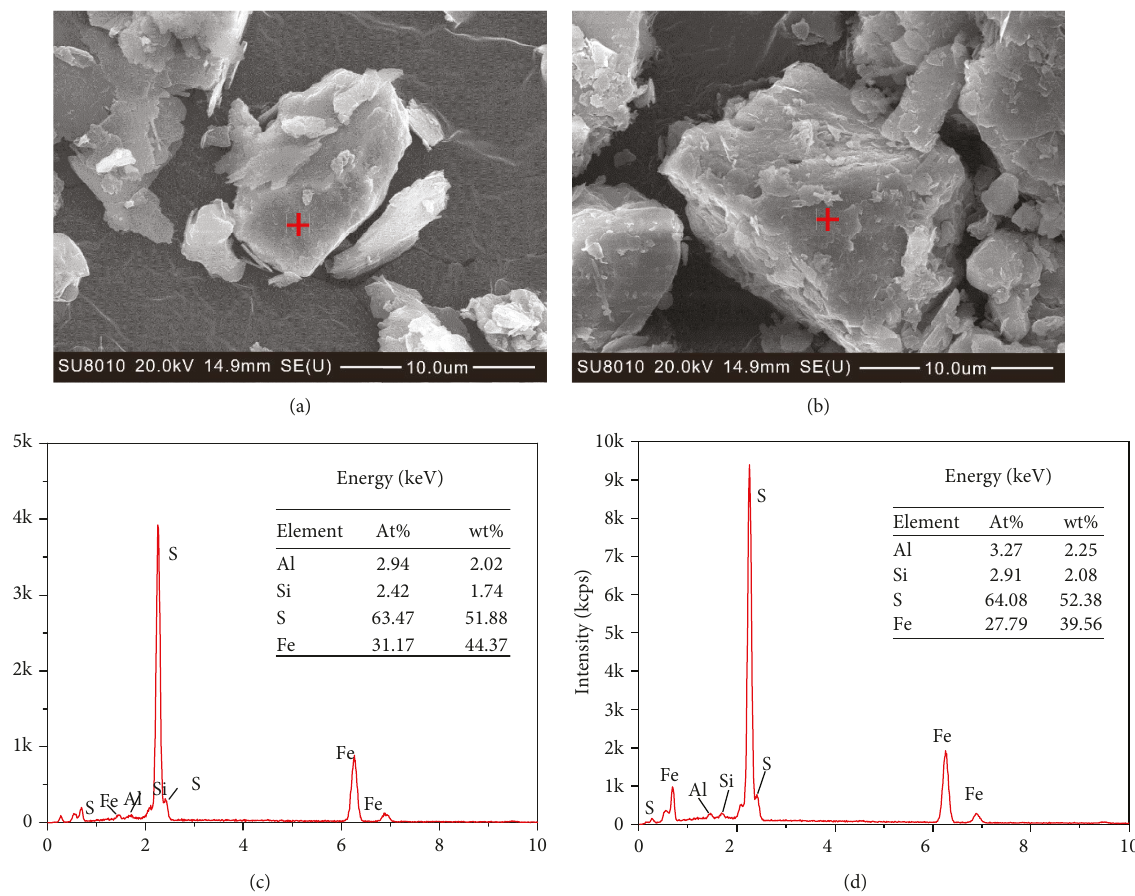
Figure 5: SEM (Scanning Electron Microscopy) and EDS (Energy Dispersive Spectrometer) photographs showing pyrites in the untreated SB2 (a, c) and SB13 (b, d) solid bitumen